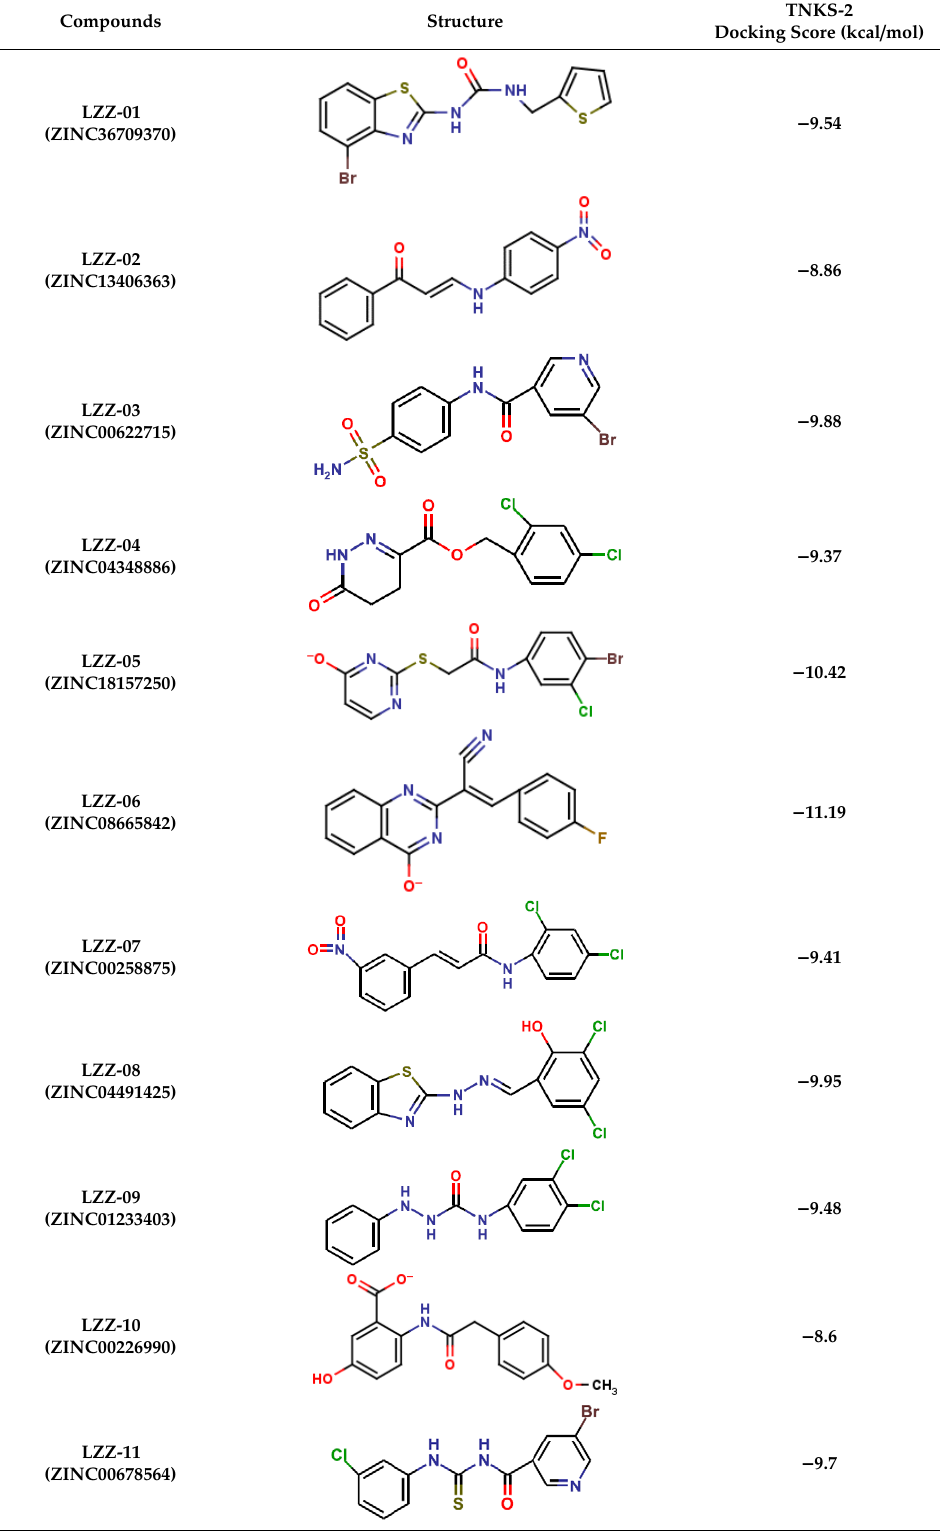
Table 1. The scoring and structures information of the selected 11 compounds. Compounds Structure